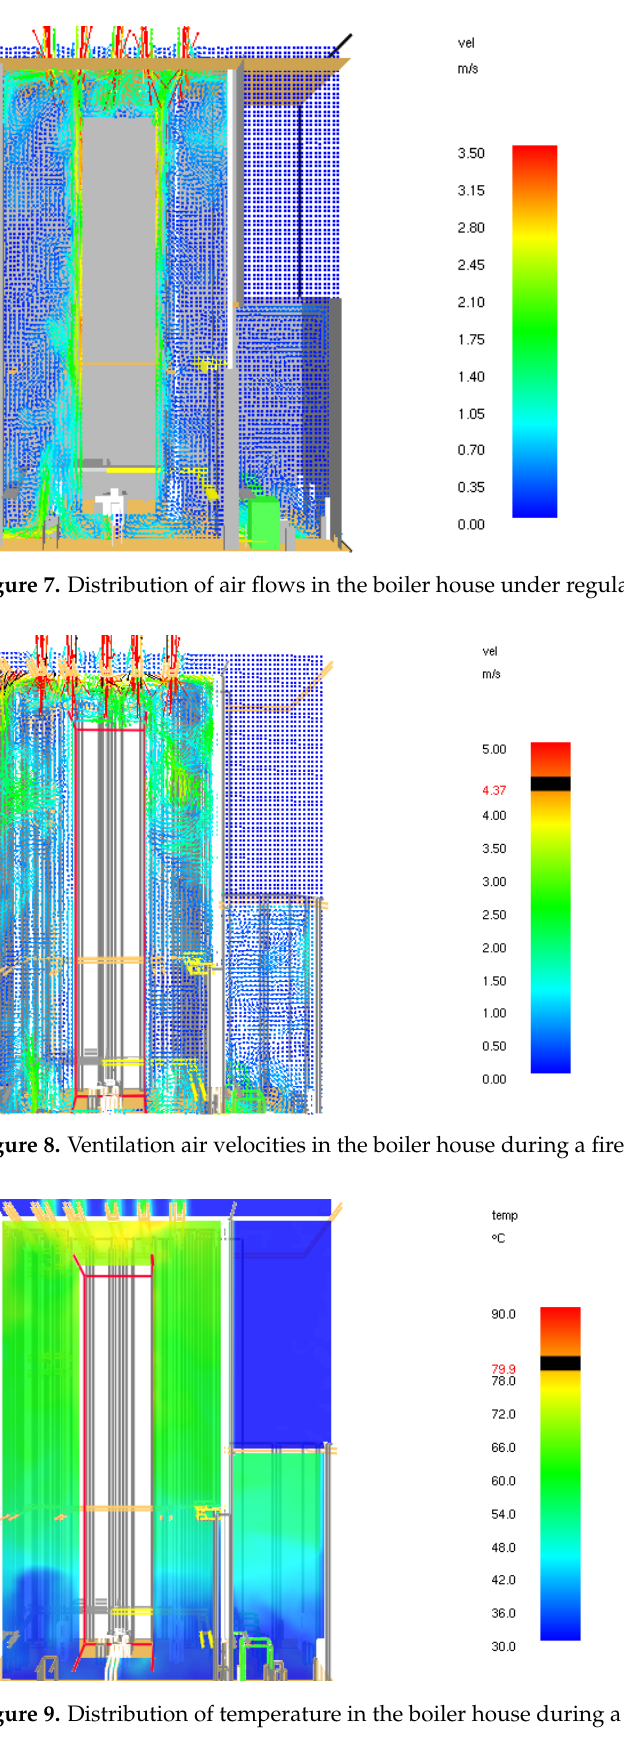
Figure 9. Distribution of temperature in the boiler house during a fire under ventilation conditions.